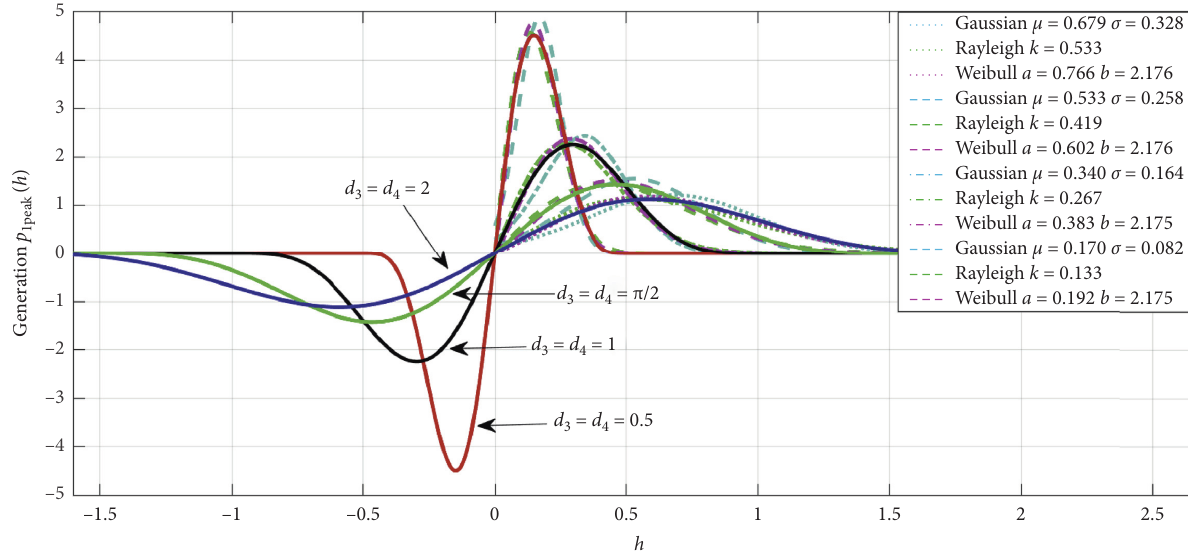
Figure 19: Generalized peak PDFs of ATNPS for different d